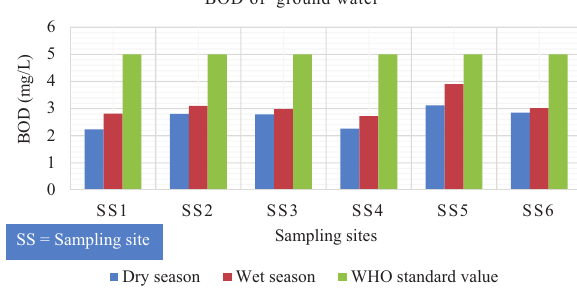
Figure 7 . Seasonal variation in the BOD of groundwater quality in the study